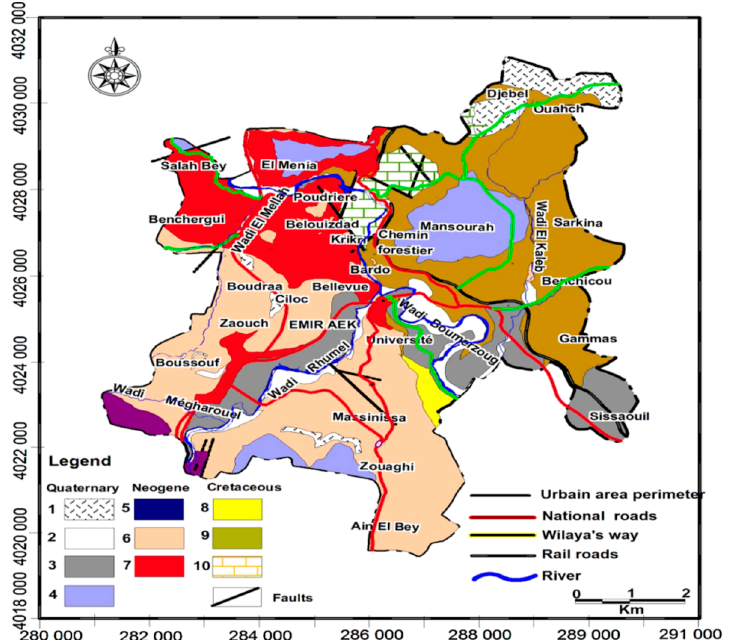
Figure 2. Lithological map of the study area: 1—Quaternary colluviums, conglomerate and thick fill; 2—quaternary recent alluvial terraces; 3—quaternary ancient alluvial terraces; 4—quaternary lacustrine calcareous formations; 5—Pliocene lacustrine calcareous formations; 6—Miocene marly clay; 7—Miocene conglomerates; 8—flysh Massylian formations (upper cretaceous); 9—Tellian Calcareous marls (Cretaceous–Eocene); 10—neritic limestone (Cenomanian–Turonian).